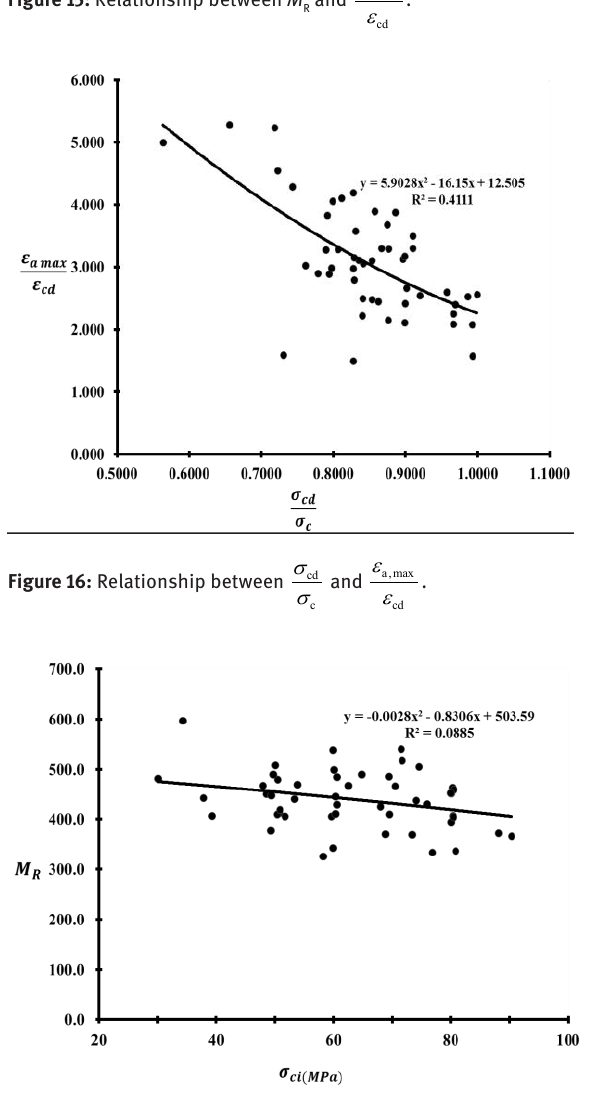
Fig. 14. Relationship between Figure 15: Relationship between M Fig. 15. Relationship between M